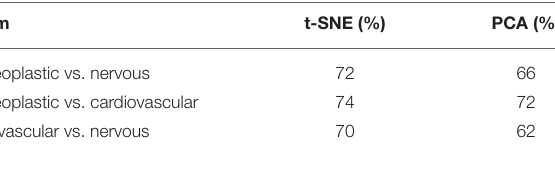
TABLE 4 | The trust results for the low-dimensional embedding (3D representation) using t-SNE and PCA.